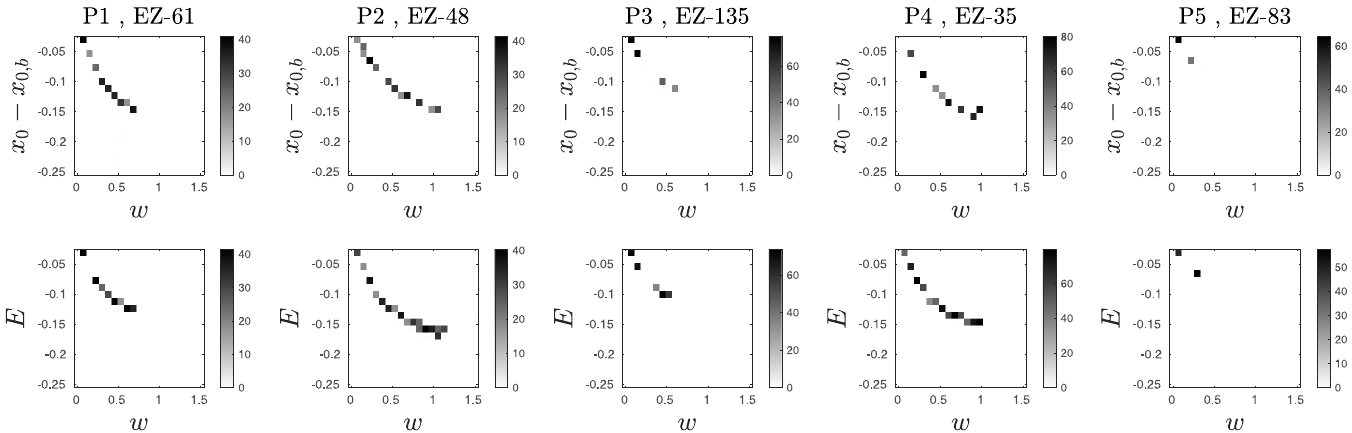
Fig 5. The proposed probabilistic model captures well the size of the fluctuations (standard deviation) in spread size across different stochastic realizations observed at the transition boundary between no-spread and spread phases. In each panel the gray scale colorbar shows the standard deviation of seizure spread across 30 different realizations. The axis of each panel follows the same convention as for the axis in Fig 2. The top row panels are for patient-specific Epileptor network simulations and the bottom row for the probabilistic model.